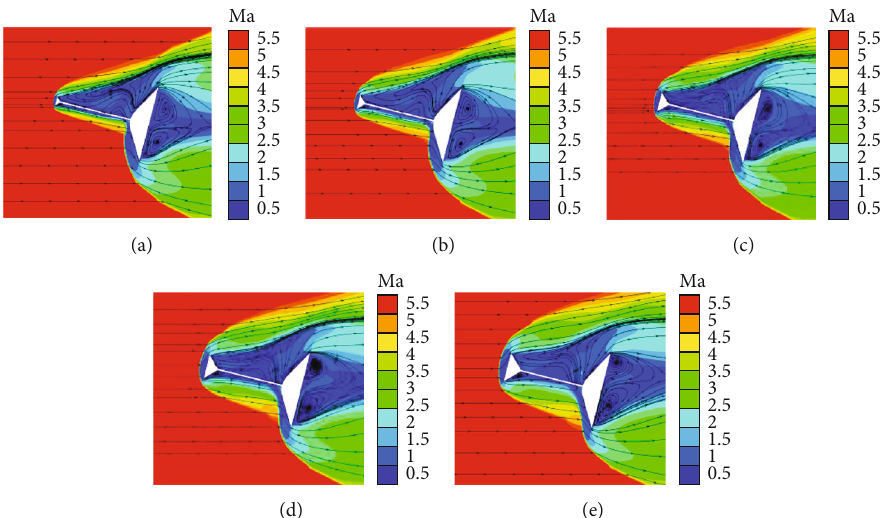
Figure 15: Mach number contours and streamline diagrams of di ff erent d / D at a pitch angle of 13.33 ° . (a) d / D = 0 : 125 . (b) d / D = 0 : 1875 . (c) d / D = 0 : 25 . (d) d / D = 0 : 3125 . (e) d / D = 0 : 375 .